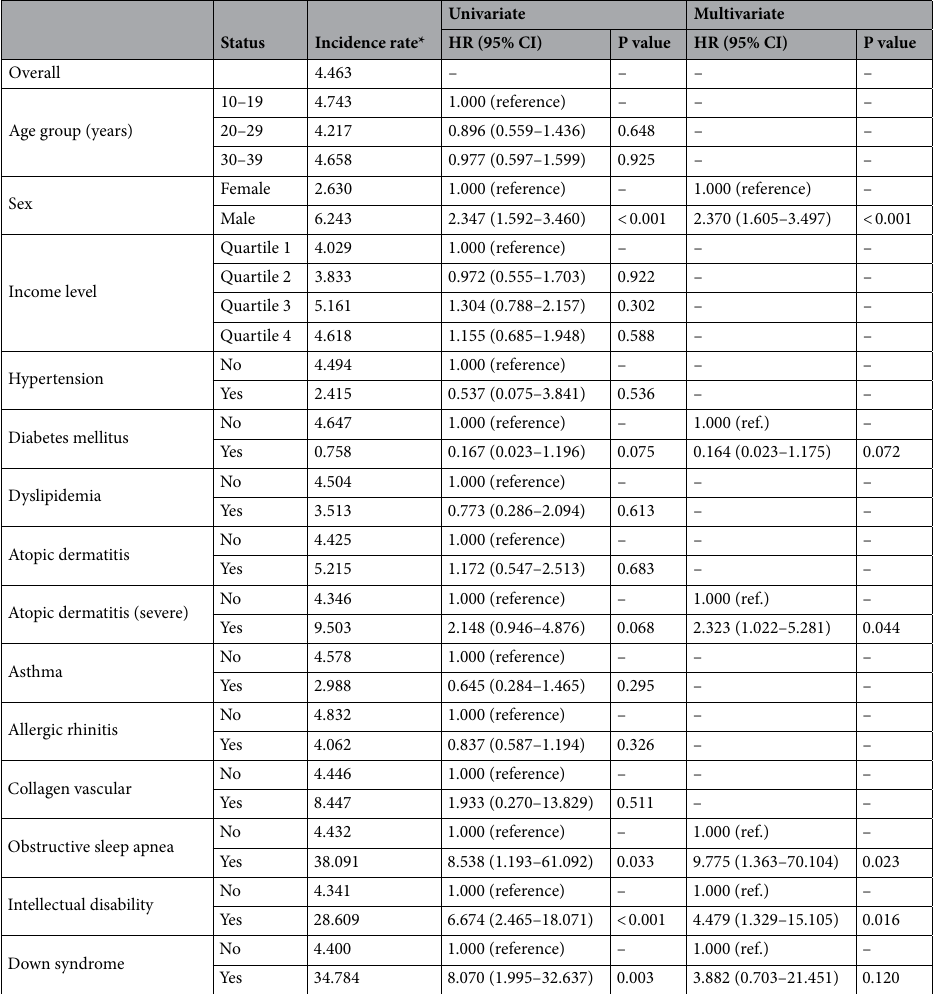
Table 2. Incidence rate and risk factors for progression to corneal transplantation in patient with keratoconus using univariate and multivariate Cox regression analyses. HR hazard ratio, CI confidence interval. *Incidence rate per 1000